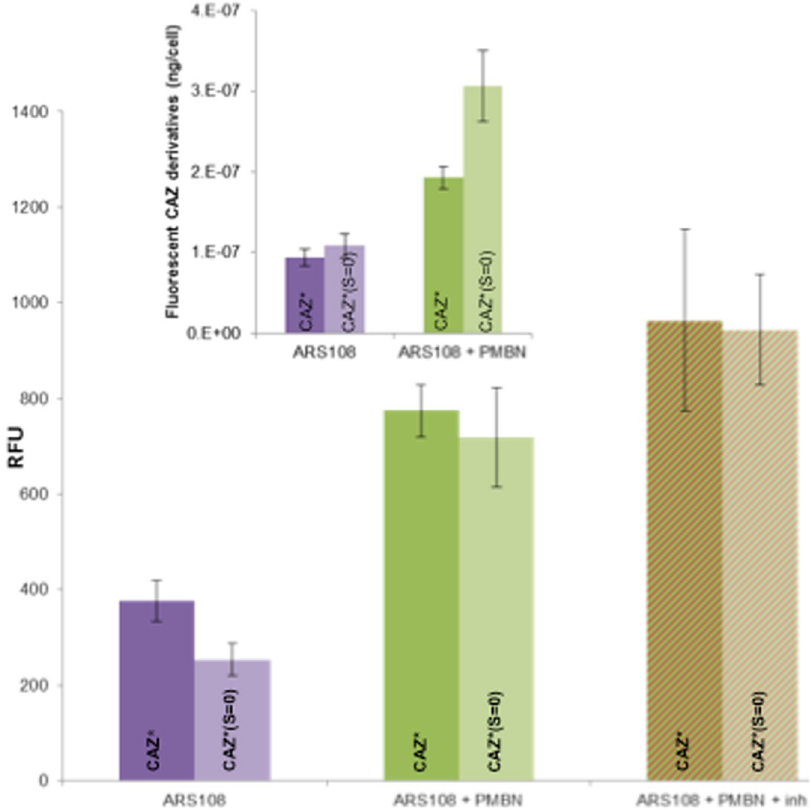
Figure 2. CAZ * and CAZ * (S = O) accumulation in bacterial population (measured on cell lysates after an incubation of 30 min). Normalized fluorescence signal corrected by the tryptophan signal and with negative controls (without CAZ * or CAZ * (S = O)). Insert: Intracellular concentration of CAZ * and CAZ * (S = O) obtained with normalization by the slope of their respective standard curve (Fig. 5S). CAZ * and CAZ * (S = O) concentrations: 32 mg/L. PMBN: final concentration 102.4 mg/L. Inh: tazobactam + clavulanic acid 4